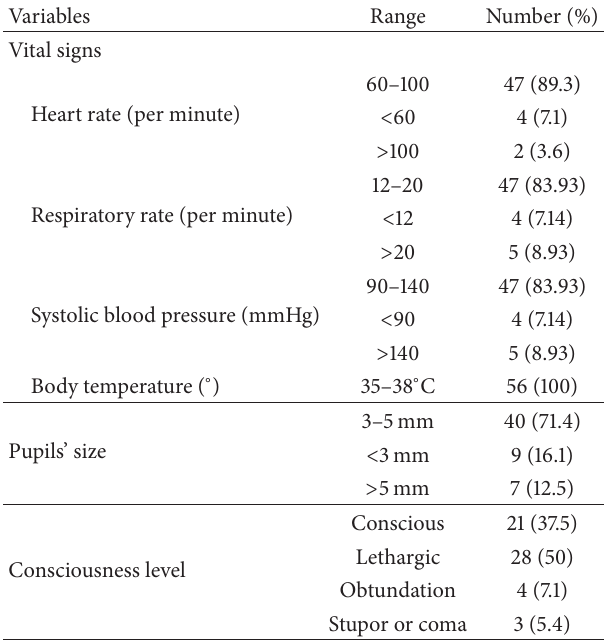
Table 2: Frequency distribution of clinical symptoms of poisoned patients presenting with